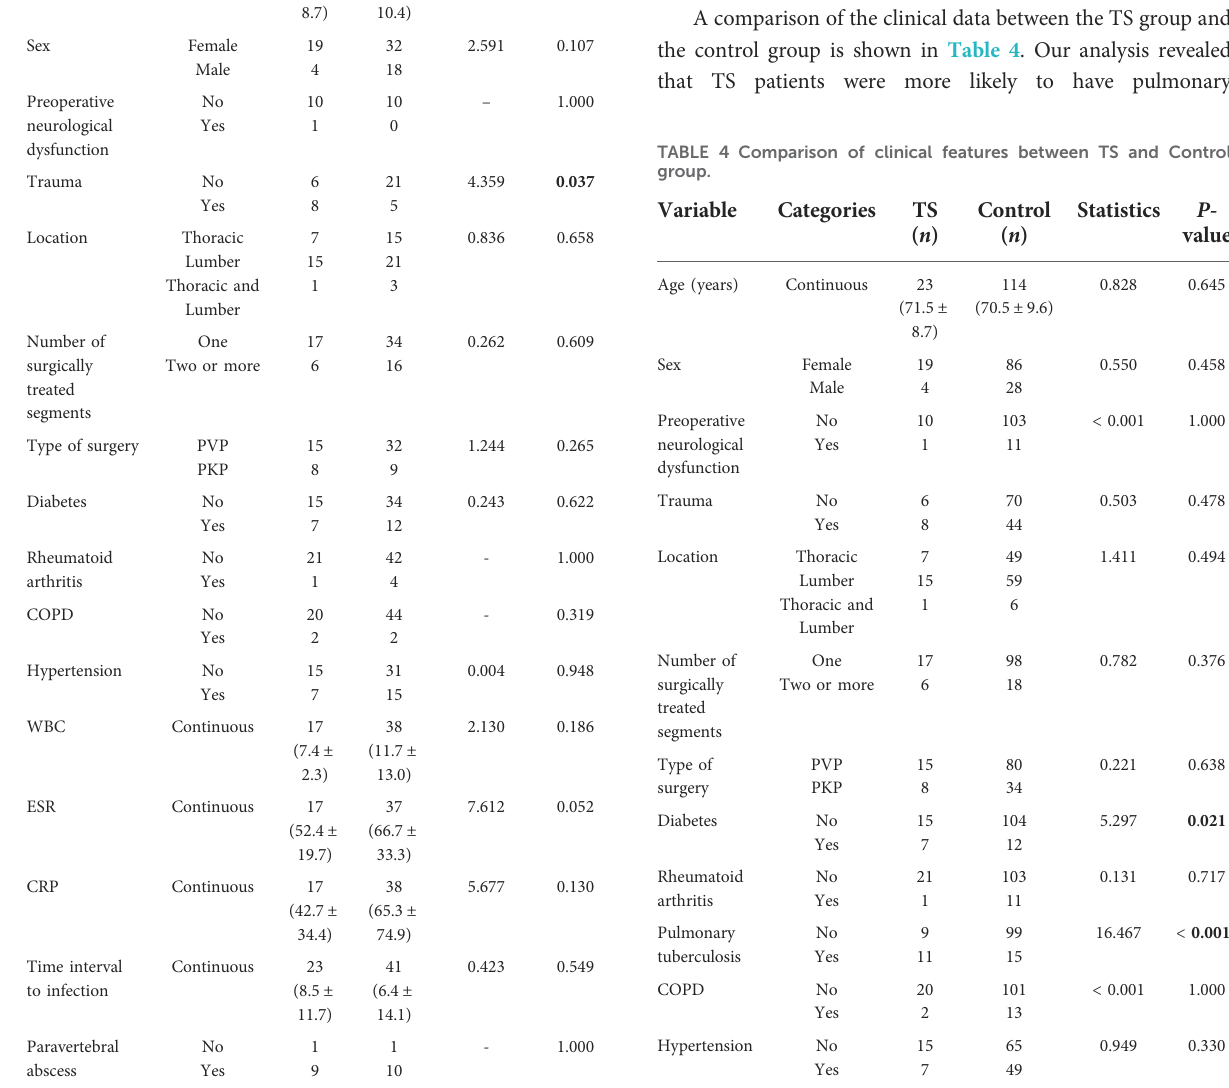
Bold values indicate P <0.05; TS, tuberculous spondylitis; PVP, percutaneous vertebroplasty; PKP, percutaneous kyphoplasty; COPD, chronic obstructive pulmonary disease; WBC, white blood cell; ESR, erythrocyte sedimentation rate; CRP, C-reactive